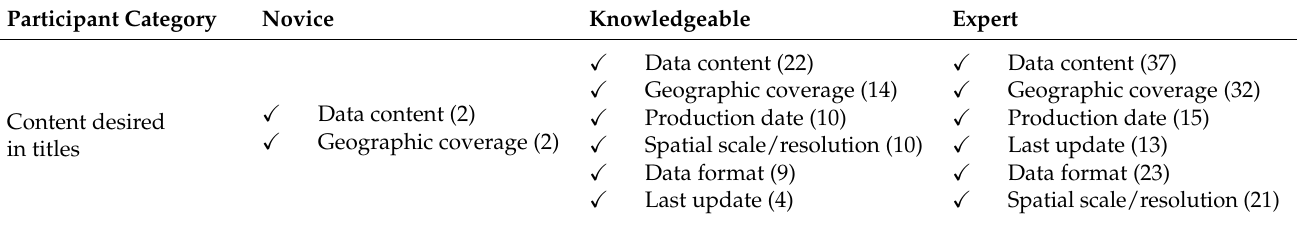
Table 9. Participants’ responses concerning content for the titles.